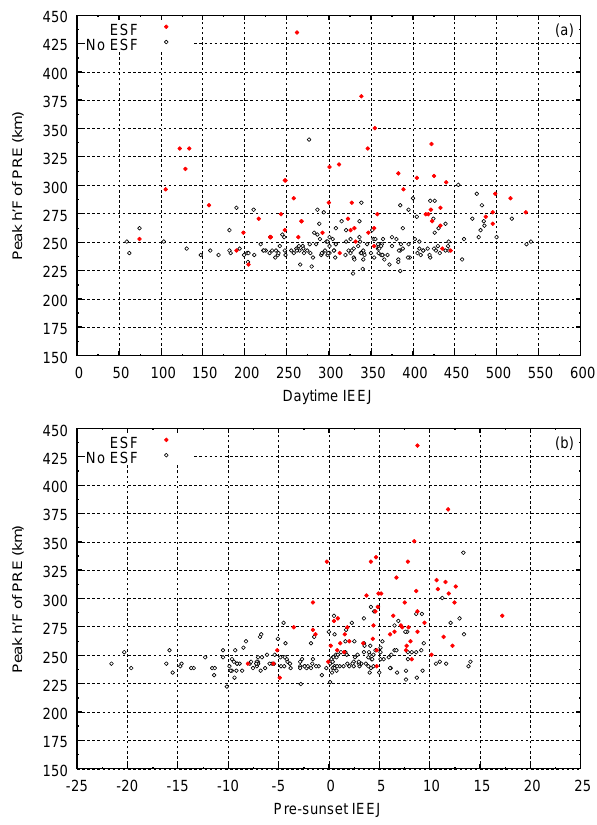
Fig. 2. Scatter plots of peak h 0 F of PRE at CPN versus daytime (a) and pre-sunset (b) IEEJ at PKT. Solid and open circles indicate the occurrence and non-occurrence of